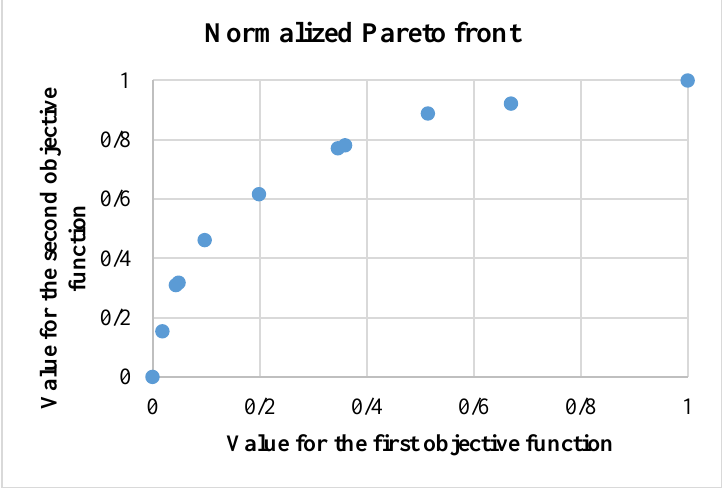
Figure 3. Normalized Pareto frontier for 11 solutions of the